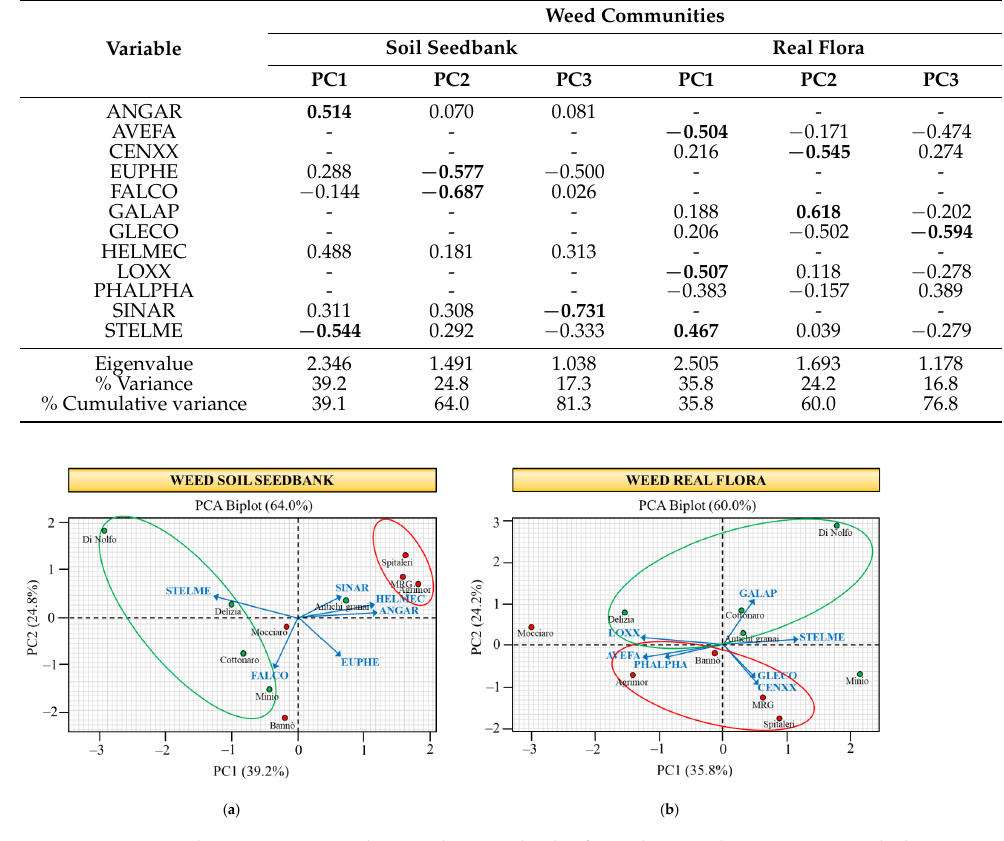
Figure 3. Principal components analysis ordination biplot from the correlation matrix with the 6 major weeds for the soil seedbank ( a ) and with the 7 major weeds for the real weed flora ( b ) across the 10 farms under study. Farms belonging to the MOD group are labelled green, while farms from the ANT group are shown with red circles. Arrows highlight the discrimination of weeds along the principal components. Groups: MOD: wheat modern varieties; OLD: wheat old landraces. Weeds: ANGAR ( Anagallis arvensis ), AVEFA ( Avena fatua ), CENXX ( Centaurea sp.), EUPHE ( Euphorbia helioscopia ), FALCO ( Fallopia convolvulus ), GALAP ( Galium aparine ); GLECO ( Glebionis coronaria ), HELMEC ( Helminthotheca echioides ), LOXX ( Lolium sp.), PHALPHA ( Phalaris paradoxa ), SINAR ( Sinapis arvensis ) and STEMLE ( Stellaria media ). Table 5. Eigenvectors and eigen analysis of the first three PCs of 12 variables (6 and 7 major weeds for the soil seedbank and real flora, respectively) from PCA on the correlation matrix. Variables with the largest influence for each principal component are in bold.